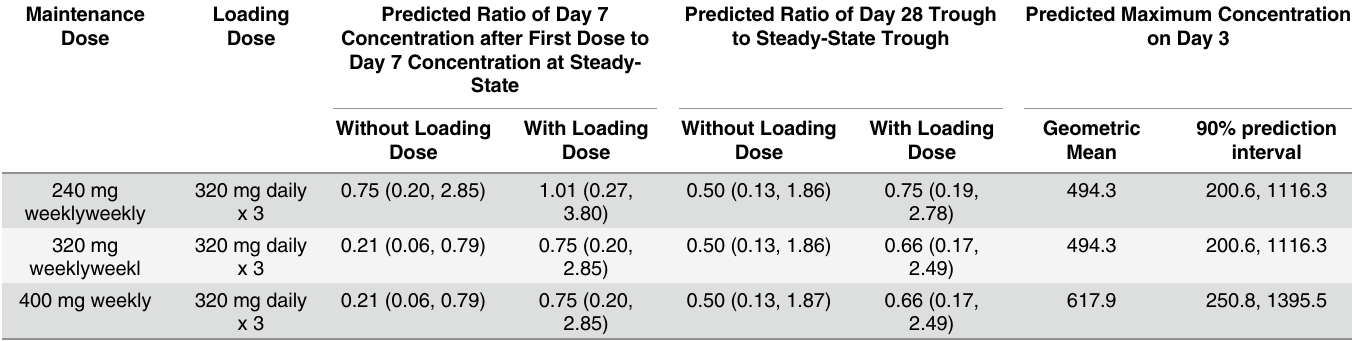
Table 3. Comparative predicted capillary plasma PQ concentrations with and without a loading dose of DP and predicted maximum concentration with a loading dose of DP in 1 – 2 year olds weighing (cid:4) 11 kg. Maintenance